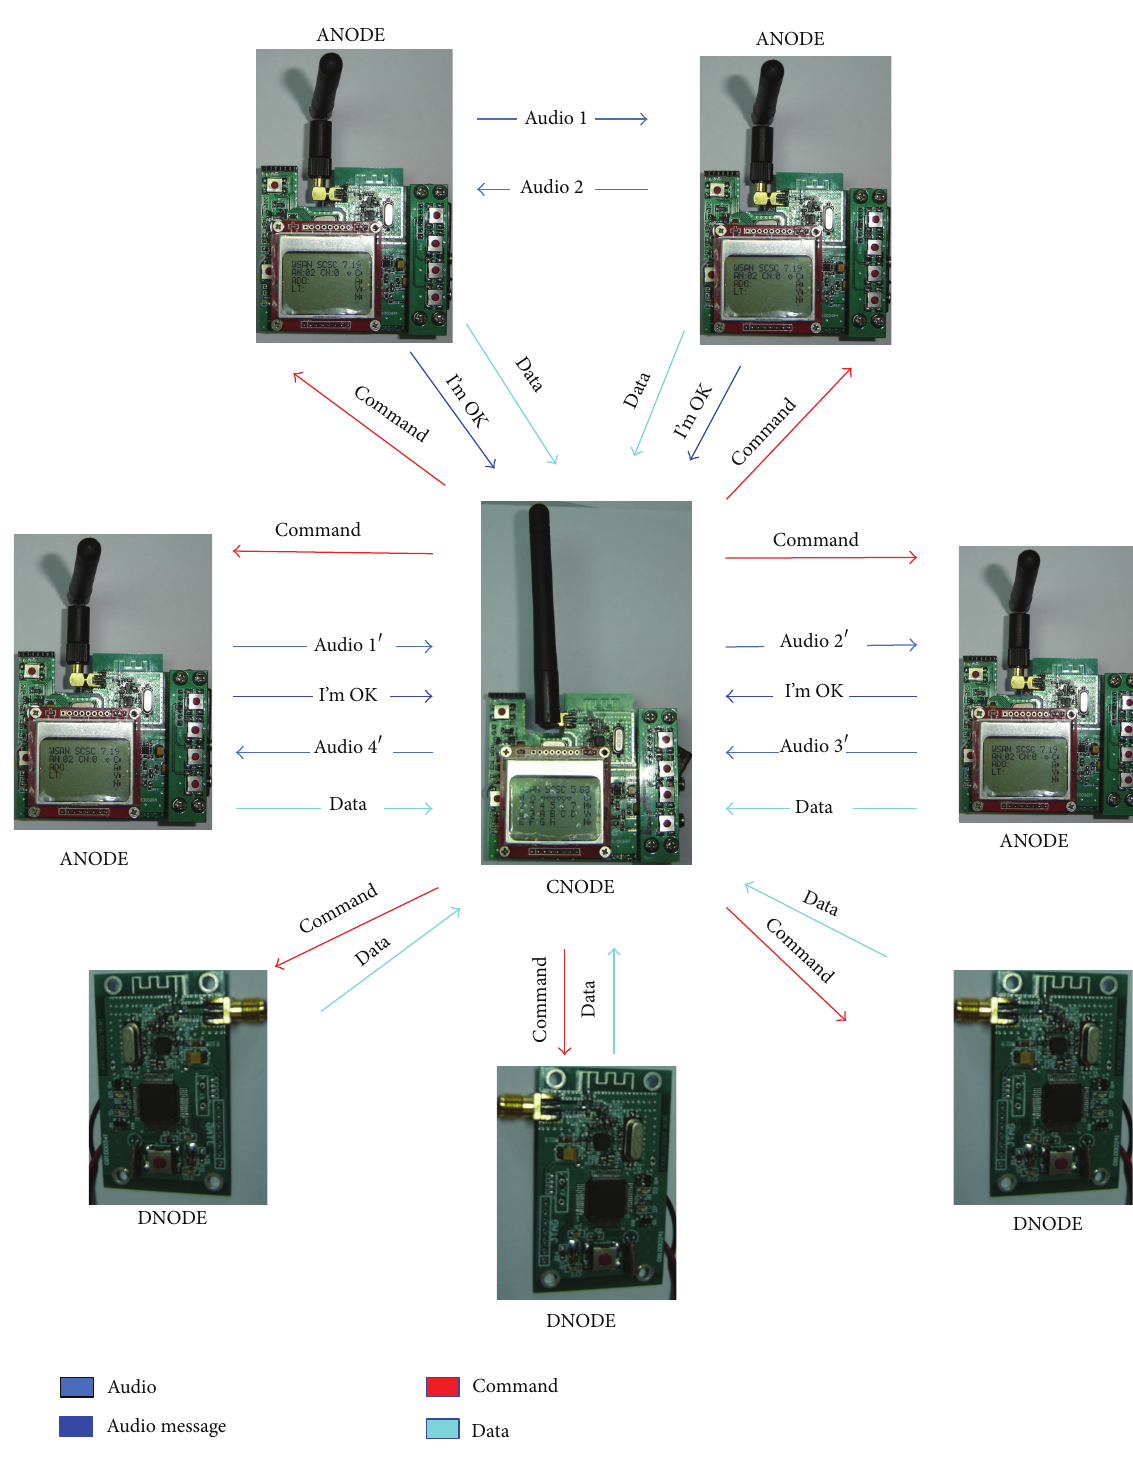
Figure 15: Schematic diagram of P2P and